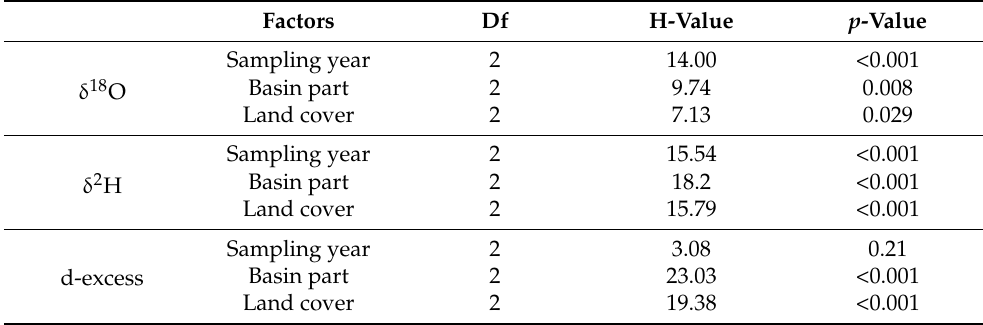
Table 3. Kruskal–Wallis test results for snow isotopic composition ( δ 18 O, δ 2 H, d-excess) among land cover types, basin parts, and sampling years.